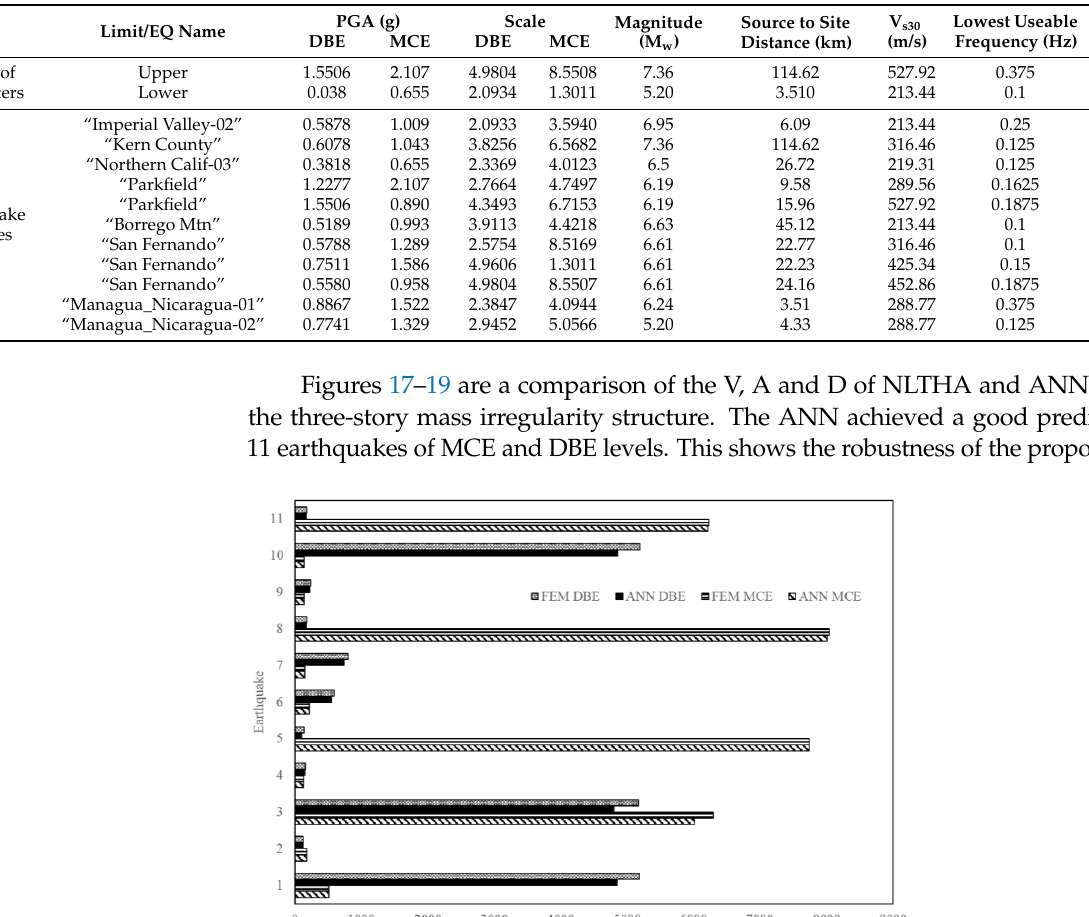
Table 4. Characteristics of design-based and maximum considered test EQs for a three-story mass irregular structure.